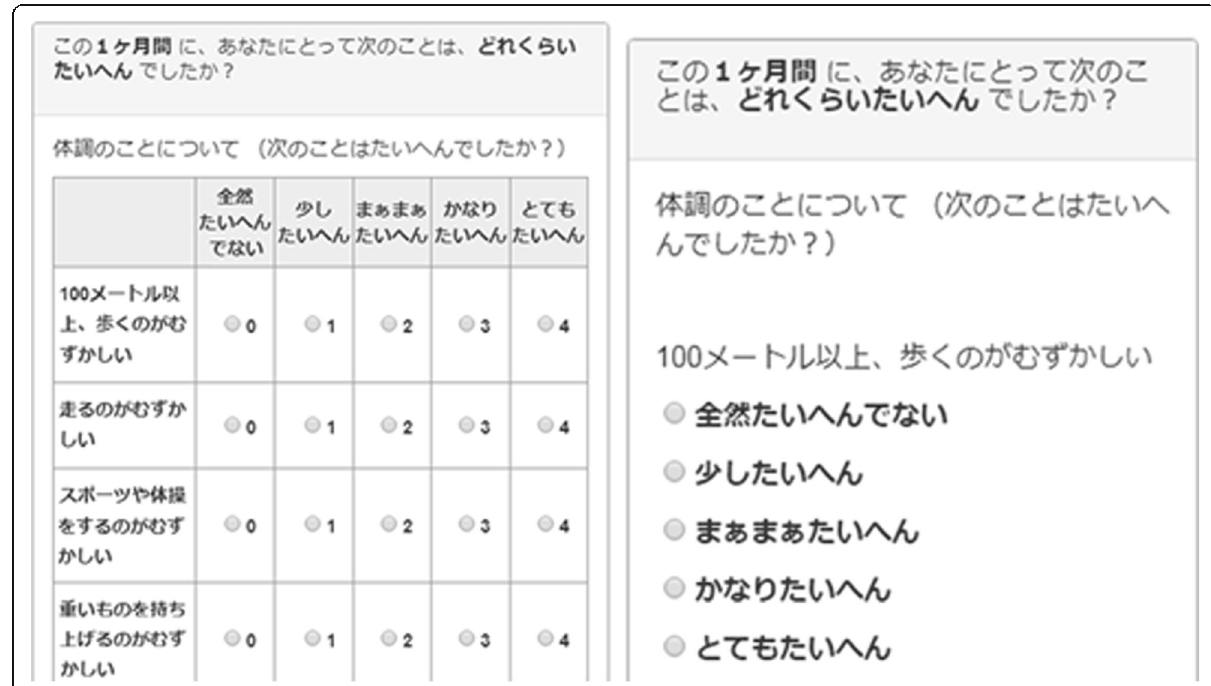
Fig. 1 General appearance of the matrix survey format and the vertical item-by-item display for small-screen devices. Actual appearance varied by user